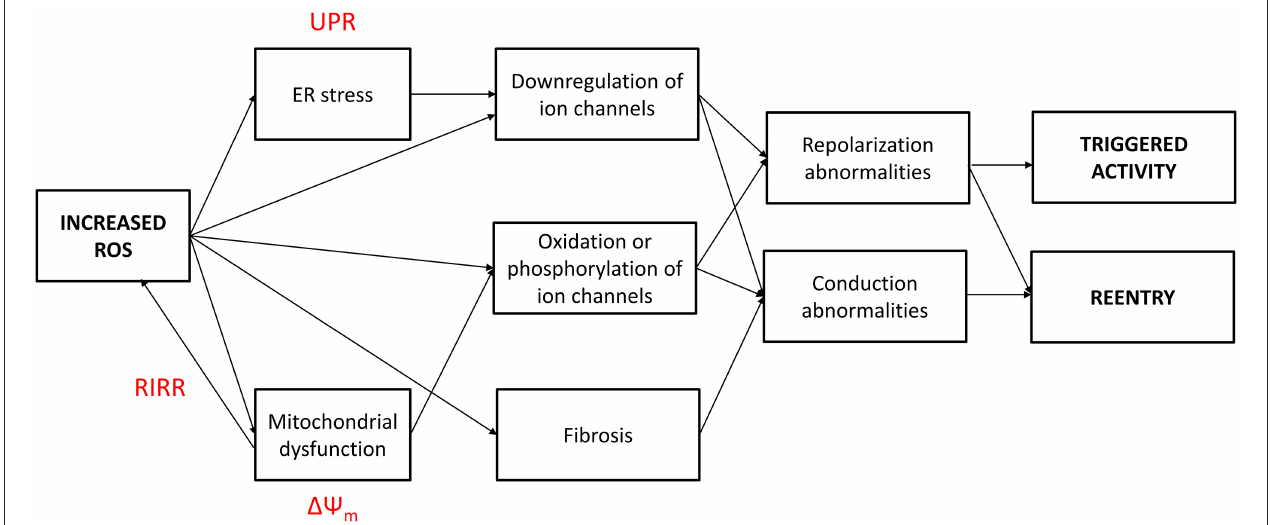
FIGURE 2 | Increased reactive oxygen species (ROS) production in cardio-metabolic disorders induce both conduction and repolarization abnormalities, thereby leading to both triggered and reentrant arrhythmogenesis. UPR, unfolded protein response; RIRR, ROS-induced ROS release; 19 m , mitochondrial inner membrane